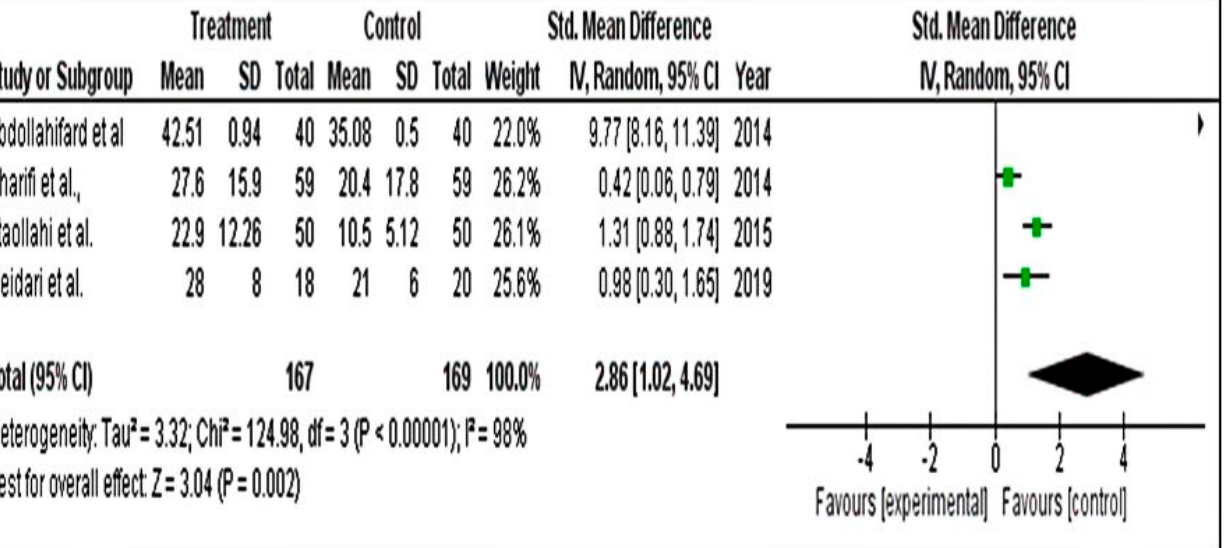
Figure 6. Forest plot for premenstrual screening tool using DSR [43,44,48,53]. Meta-Analysis for PMTS Scores